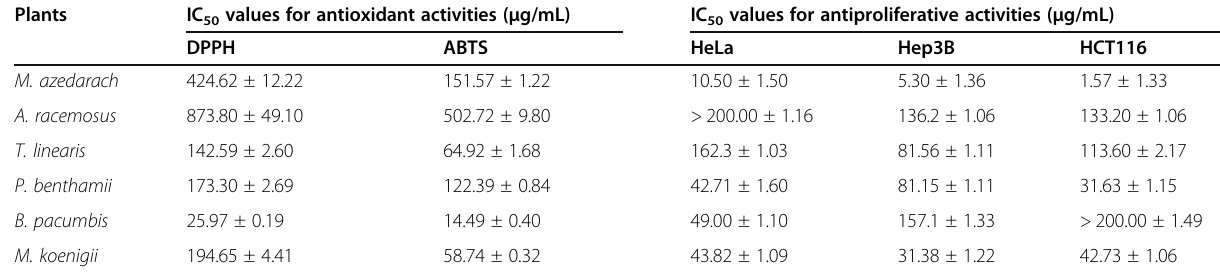
Table 4 Results on antioxidant and anticancer activities Plants IC 50 values for antioxidant activities ( μ